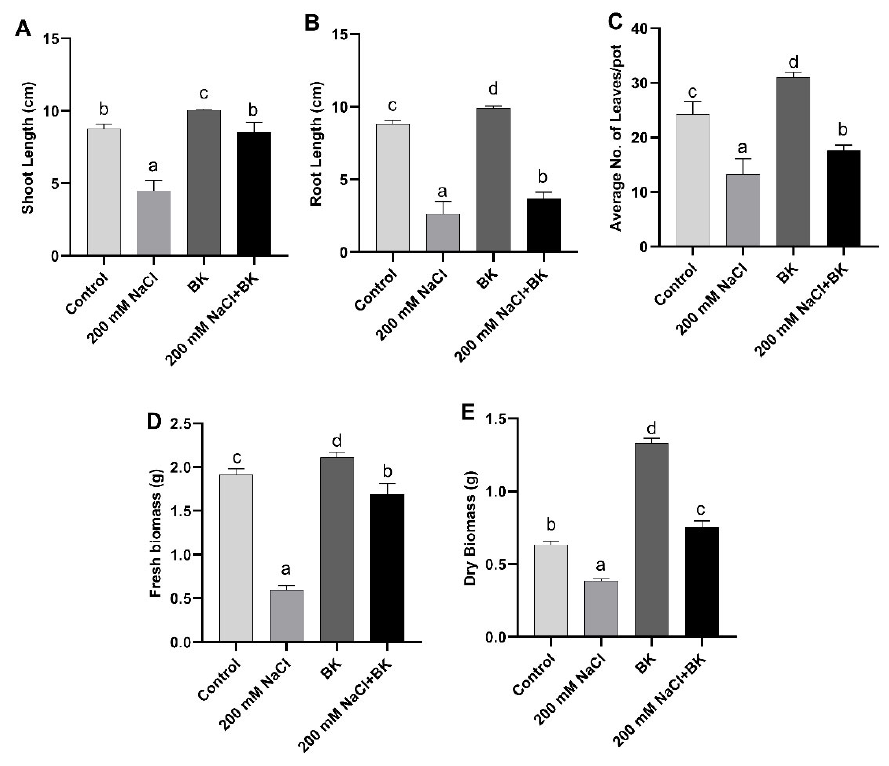
Figure 2. Influence of A. welwitschiae BK on vegetative growth parameters. ( A ) Shoot length, ( B ) root length, ( C ) average number of leaf/pots, ( D ) fresh biomass, and ( E ) dry biomass of maize grown under salt stress. Data represent the means and SE of three independent replicates for each treat- ment. Signi fi cant di ff erences ( p ≤ 0.05) are marked with di ff erent le tt ers.